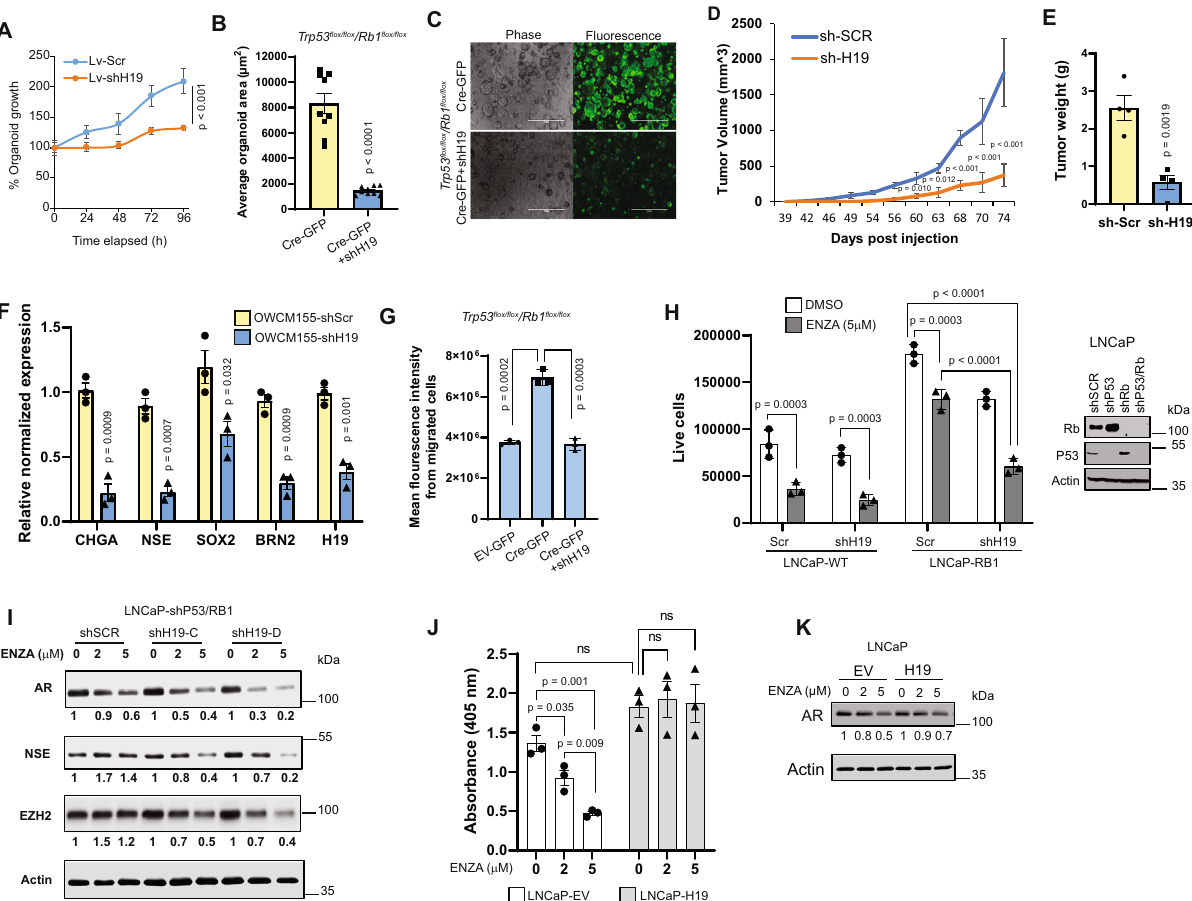
Fig. 4 Elevated H19 is essential for proliferation and invasion of NEPC-like cells and sensitizes to Enzalutamide (ENZA) growth inhibition. A OWCM- 155 NEPC organoid cells (5000/well) were plated with or without stable H19 knockdown (Lv-shH19 or Lv-Scr). Line graphs demonstrate the quanti fi cation of organoid growth. B Trp53 fl ox/ fl ox /Rb1 fl ox/ fl ox mouse organoid cells (5000/well/condition) were plated. Bar plot represents organoid area quanti fi cation ( n = 10; biological replicates) C Representative fl uorescence images of organoids in Fig. 4B. Scale bar: 1000 μ m. D Time course of OWCM-155 control (shScr) and H19 KD (shH19) tumor xenograft growth in n = 5 NSG mice. E Mean tumor weight of the tumor xenografts ( n = 4) harvested at 11-week post- injection. F Relative mRNA expression of H19 and NE markers in OWCM-155 shH19 vs. OWCM-155 shScr xenografts. Each bar represents pooled data from tumors from three different mice per group. G Organoid invasion assay. Transwell assay using FluoroBlock inserts with 50,000 cells/well of Trp53 fl ox/ fl ox / Rb1 fl ox/ fl ox organoids transduced with EV-GFP, Cre-GFP, and Cre-GFP + shH19 ( n = 3). Quanti fi cation by fl uorescence intensity of the migrated cells on the bottom of the transwell, fi ve days post-plating. EV-GFP was used as a control. H Growth response (left) of LNCaP cells with WT and P53/RB1 knockdown (shP53/RB1) with and without H19 knockdown (shH19 vs. Scr) treated with ENZA (5 µ M) for 5 days. DMSO was used for the control treatment. WB (right) of these cells shows the RB and P53 knockout. I WB of LNCaP shP53/Rb1 cells with and without two different shH19 (shH19-C, shH19-D) treated with ENZA (2, 5 µ M). DMSO was used as a control. J , Growth response of LNCaP cells overexpressing H19 vs. empty vector (EV) treated with ENZA (2, 5 µ M) for 5 days. DMSO was a control treatment at 0 μ M. K Western blot of LNCaP cells used in ( J ) treated with ENZA (2, 5 µ M; 72 h). In H , I , and K , WB images were quanti fi ed using ImageJ (Methods) with Actin as a control. Data are mean ± SD ( D , G , H ), or mean ± SEM ( A , B , E , F , J ); n = 3 ( F – H , J ) biologically independent replicates. p Values were calculated by unpaired two-tailed Student ’ s t test ( A , B , D – G , J ) or Tukey ’ s multiple comparisons test ( h